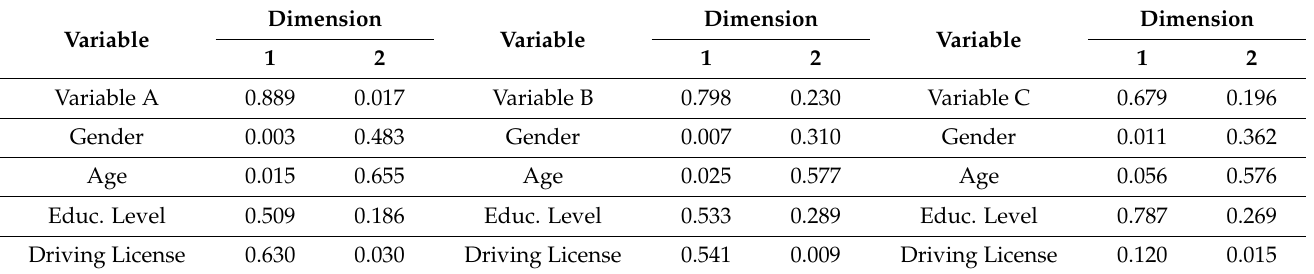
Table 6. Discrimination measures of the variables.